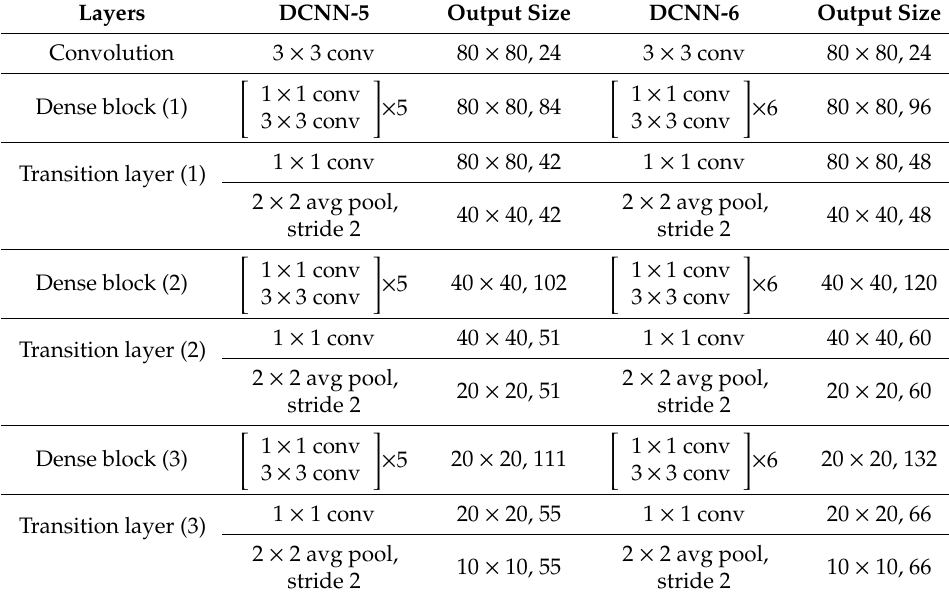
Table 1. Dense convolutional neural network (CNN) architecture for multi-scale feature extraction in high spatial resolution (HSR) land-cover classification.